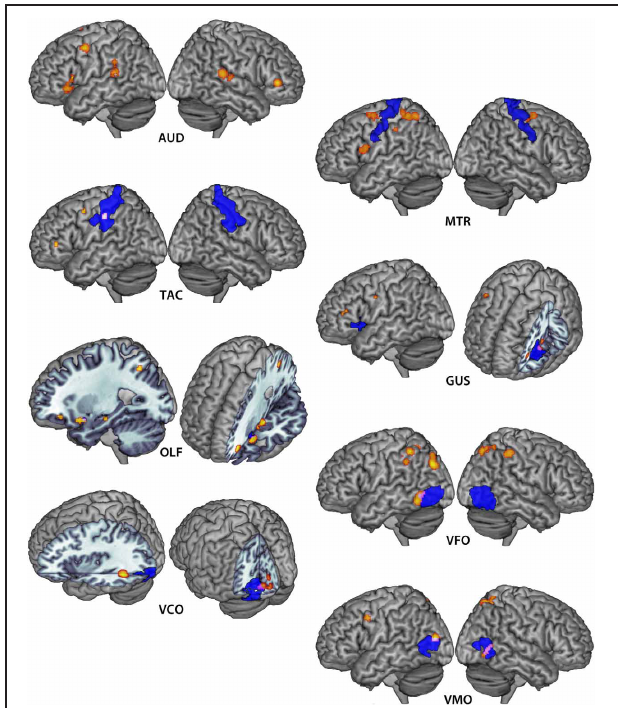
FIGURE 2 | Extent-thresholded clusters of voxels reaching pN < 0 . 05 significance in the auditory (AUD), motor (MTR), tactile (TAC), gustatory (GUS), olfactory (OLF), visual form (VFO), visual color (VCO) and visual motion (VMO) imagery ALE maps are depicted in warm values. Corresponding primary sensorimotor cortices are depicted in violet. Overlapping regions are depicted in